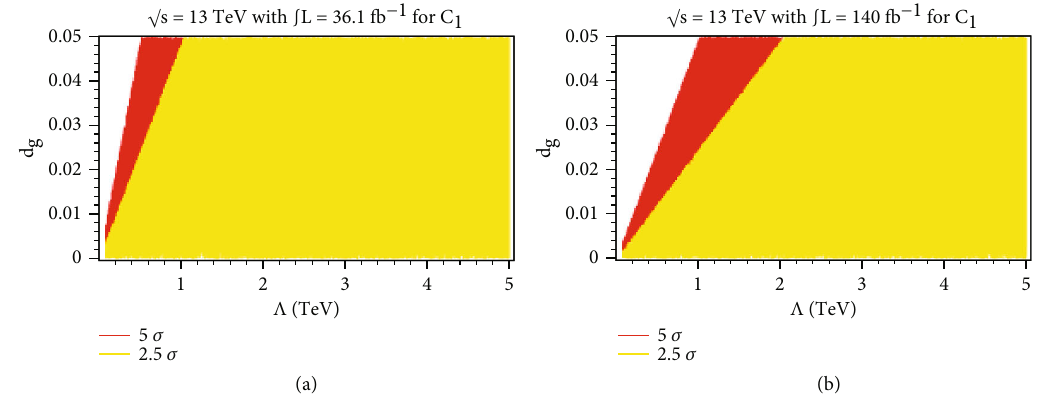
ffiffiffi p at = 13TeV energy at LHC for an integrated luminosity of (a) 36 : 1 fb − 1 and (b) 140fb − 1 respectively. S 1